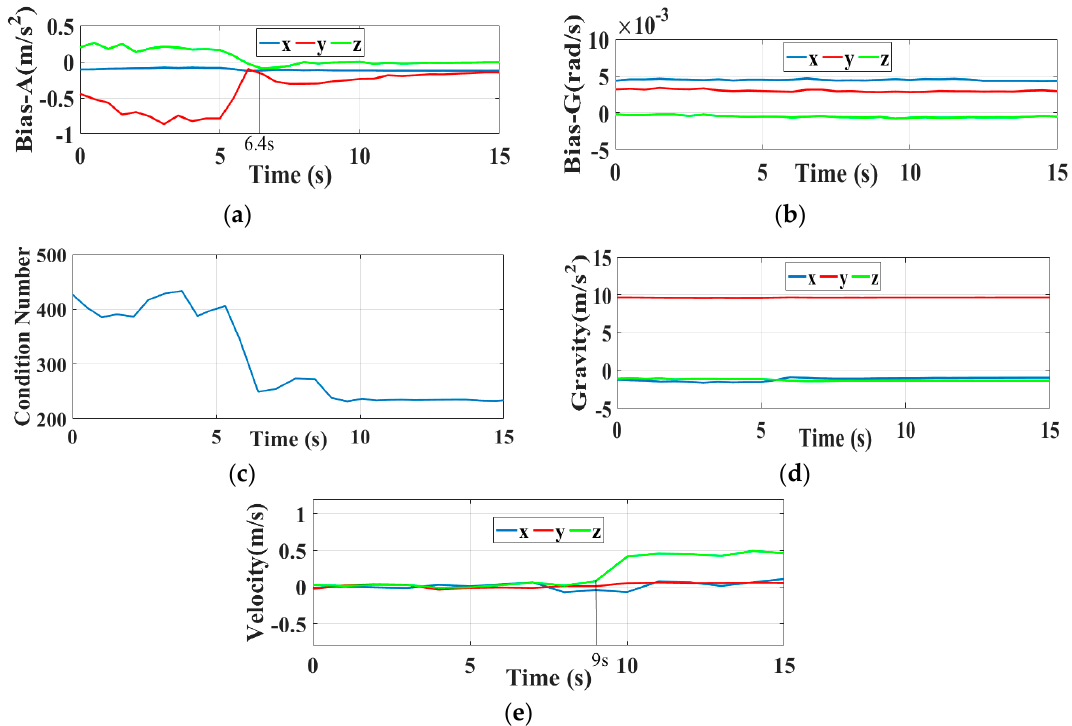
Figure 12. The convergence procedures of the initialization states in the substation scene tests, ( a )